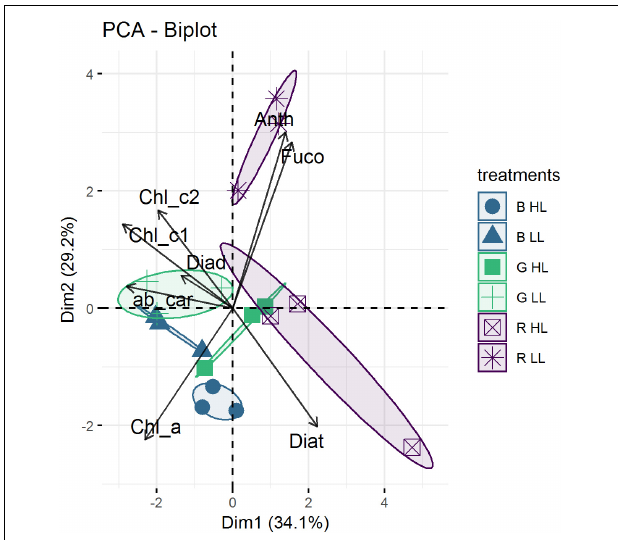
FIGURE 8 | Representation of Principal component analysis (PCA) calculated with pigment percentages from µ g.g − 1 . The first two PCA dimensions accounted for 29.3 and 26.2%, respectively, of the total variance. Replicates of the same treatment ( n = 3) are grouped by confidence interval ellipses (0.95).